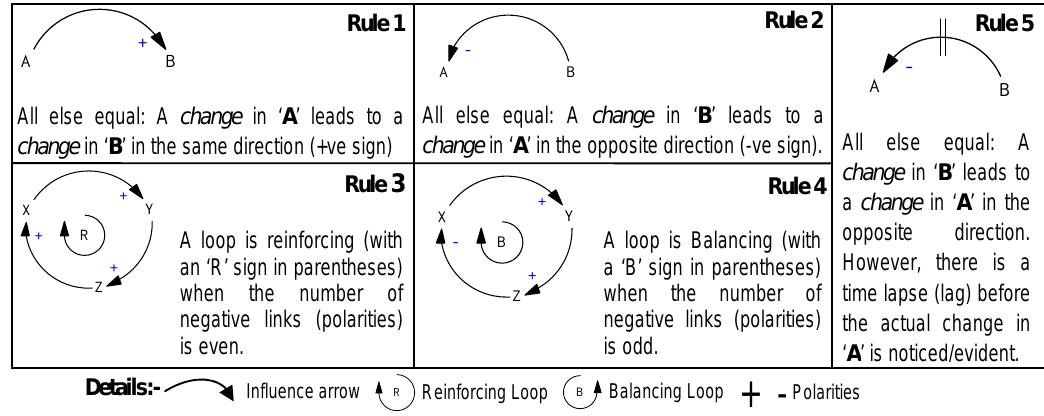
Figure 3. A summary of the causal loop diagram